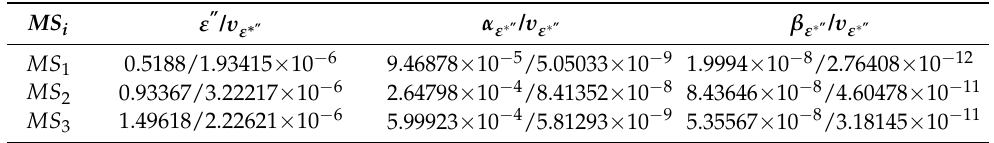
Table 7. The values of ε (cid:48)(cid:48) , α ε ∗(cid:48)(cid:48) and β ε ∗(cid:48)(cid:48) for MSs.